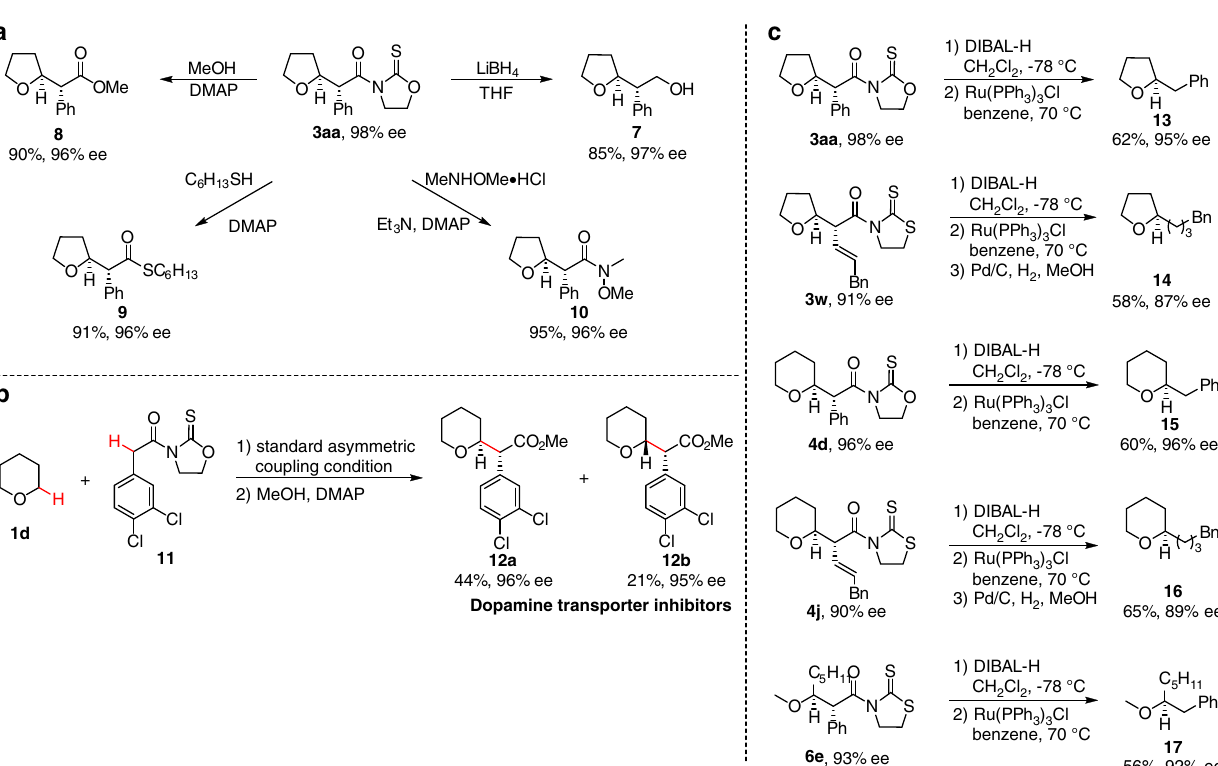
Fig. 5 Synthetic utilities. a Transformations of oxa- and thiazolidinethiones to other synthetically valuable functional groups. b Rapid synthesis of two dopamine transporter inhibitors. c Removal of the oxa- and thiazolidinethione moieties